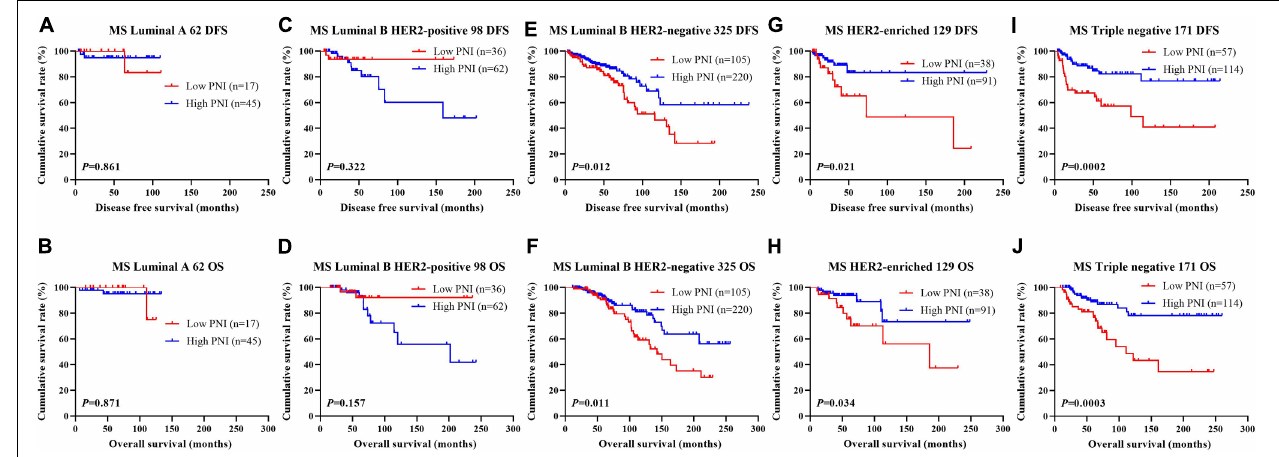
FIGURE 3 | Disease-free survival (DFS) and overall survival (OS) for the prognostic nutritional index (PNI) of patients with breast cancer in different molecular subtypes. (A,B) Kaplan–Meier analysis of DFS (A) and OS (B) for the PNI of patients with luminal A breast cancer in all enrolled patients. (C,D) Kaplan–Meier analysis of DFS (C) and OS (D) for the PNI of patients with luminal B HER2-positive breast cancer in all enrolled patients. (E,F) Kaplan–Meier analysis of DFS (E) and OS (F) for the PNI of patients with luminal B HER2-negative breast cancer in all enrolled patients. (G,H) Kaplan–Meier analysis of DFS (G) and OS (H) for the PNI of patients with HER2-enriched breast cancer in all enrolled patients. (I,J) Kaplan–Meier analysis of DFS (I) and OS (J) for the PNI of patients with triple-negative breast cancer in all enrolled patients.